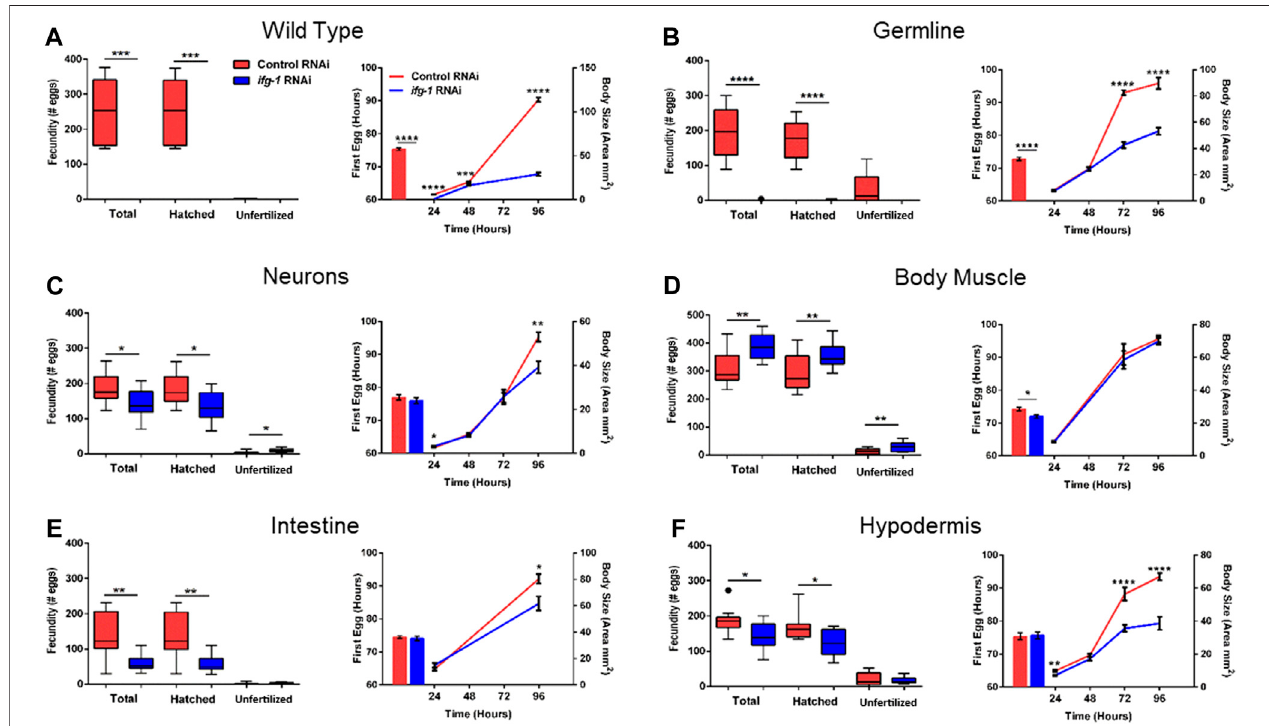
FIGURE 4 | Reduced translation in muscle has opposing effects on reproduction and growth compared with reduced translation in other tissues. Gravid adults were placed on bacteria expressing control or ifg-1 dsRNA and allowed to lay eggs for 1 h. Adults were removed and larvae monitored for growth and fecundity. Reproduction was measured separately for hatched progeny and unfertilized eggs (left panel). Sexual maturation rate was measured from the time an egg was laid through development to becoming an egg-laying adult (right panel). Growth rate was determined by monitoring body size for 96 h after being laid (right panel). (A) Knockdown of ifg-1 in N2 wild type animals signi fi cantly diminished fecundity, development, and growth. (B) Germline knockdown of ifg-1 also signi fi cantly decreased fecundity, development, and growth. (C) Knockdown of ifg-1 in the neuron-speci fi c RNAi strain signi fi cantly decreased total and hatched offspring, had no effect on development and signi fi cantly reduced growth. (D) Knockdown of ifg-1 in the body muscle-speci fi c strain signi fi cantly increased fecundity, reduced the time to reproductive adulthood, and had no effect on growth. (E) Intestinal knockdown of ifg-1 signi fi cantly decreased fecundity and growth with no signi fi cant change in development. (F) Hypodermal knockdown of ifg-1 signi fi cantlydecreasedtotalfecundity andgrowthwithnosigni fi cantchangeintherateofdevelopment.9 – 16animals per condition were assessed for reproduction and growth at each time point. 8 – 19 animals were assessed for development. All assays were replicated with similar results. Error bars on bar and line graphs (right panels) represent standard error of the mean. Signi fi cance in Tukey box plots (left panels) as well as bar and line graphs was calculated using unpaired t-test with Welch ’ s Correction (* p < 0.05, ** p < 0.01, *** p < 0.001, **** p < 0.0001). Data points outside the whiskers of the box plot are shown. Data were pooled from two